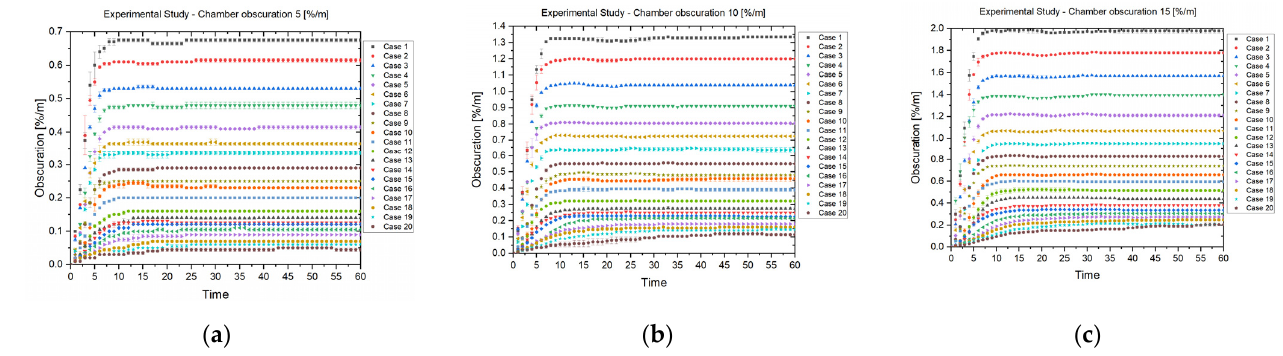
Figure 8. The obscuration at ASD ( a ) When chamber obscuration was 5%/m ( b ) When chamber obscuration was 10%/m ( c ) When chamber obscuration was 15%/m.